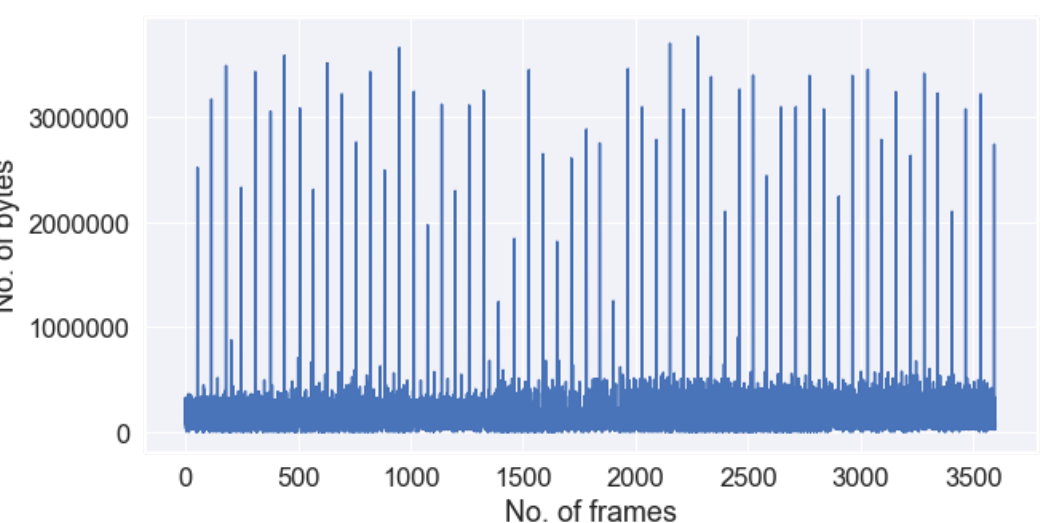
Figure 34a. Disk reads in S2.6.